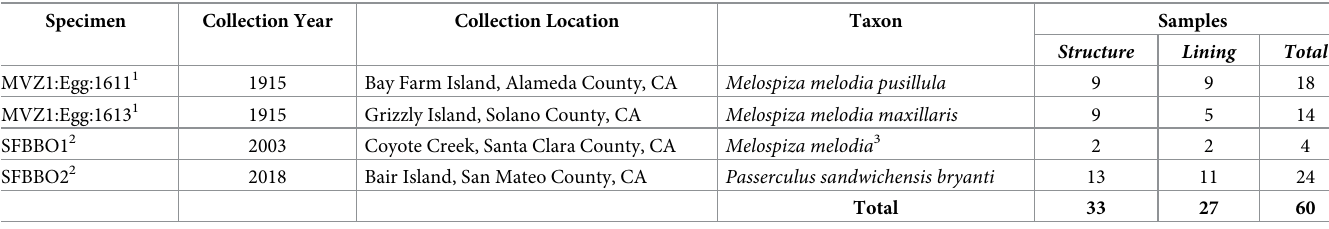
Table 1. Bird nest specimens selected for sampling.